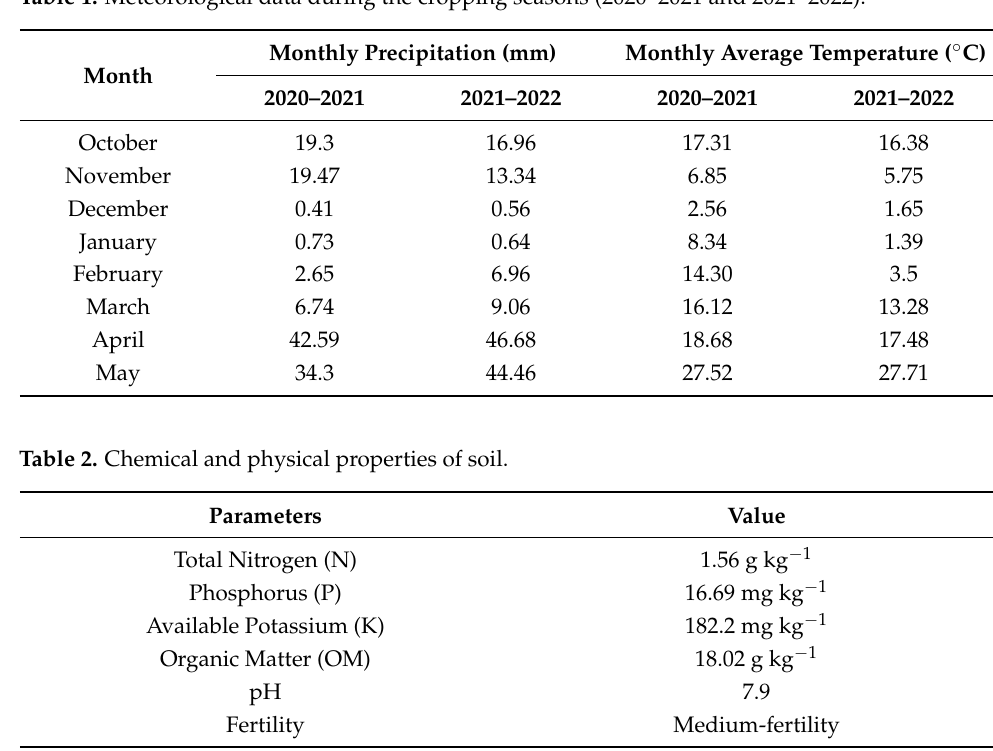
Table 1. Meteorological data during the cropping seasons (2020–2021 and 2021–2022). Month